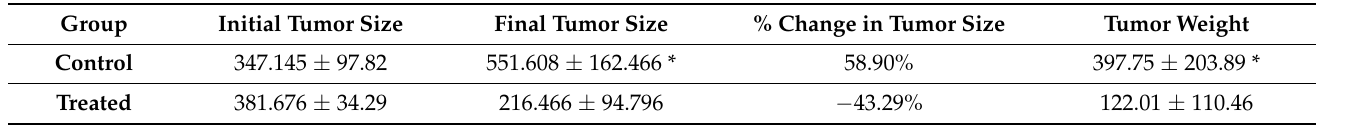
Table 5. Effect of ethanol extract of L. angustifolia on tumor size (mm 3 ) and weight (mg) of EMT-6/P cell line.